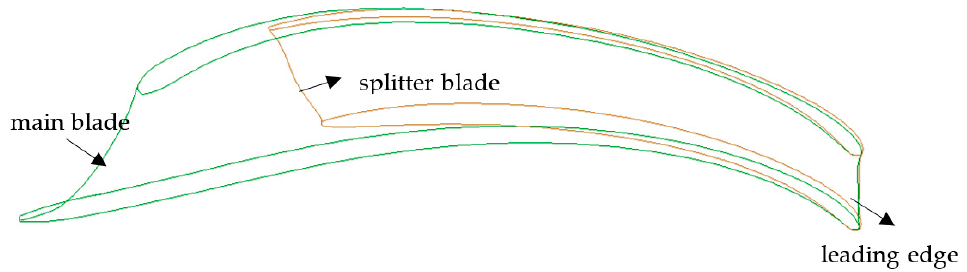
Figure 14. The comparison of geometry between main blade and splitter blade.